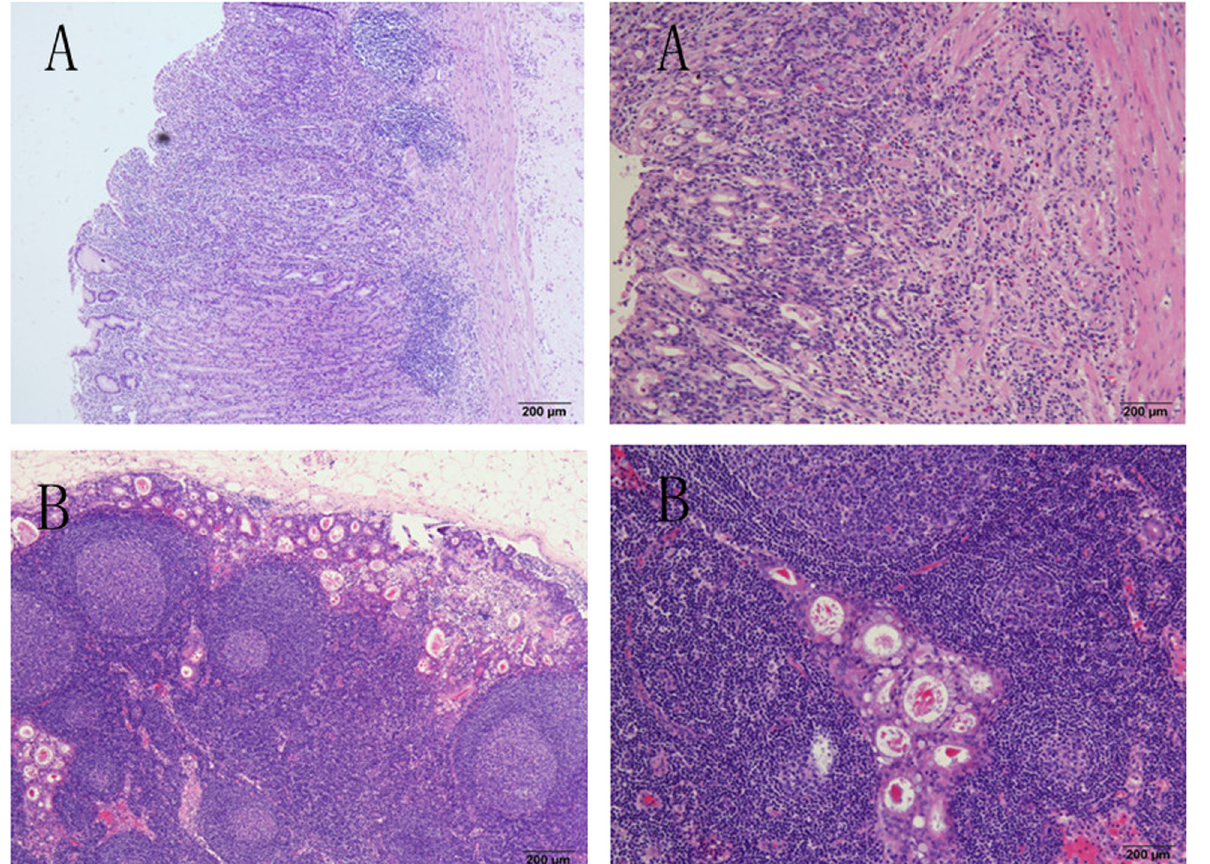
Fig 2. LNM occurred in a sub-mucosal gastric cancer patient shown in the H-E staining